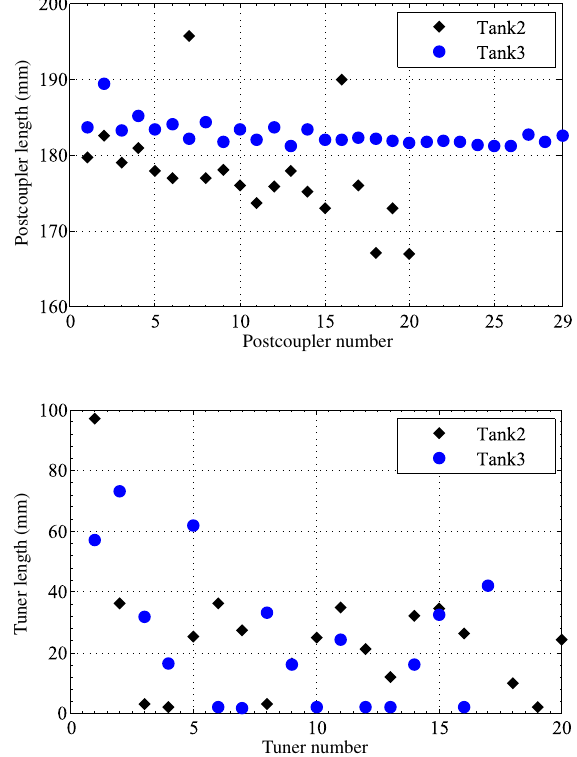
FIG. 10. Top: post-coupler lengths, bottom: tuner lengths of Tank 2 (diamonds) and Tank 3 (dots). The two post-couplers with exceptional over-length are due to an additional tuner piece that had been installed on these post-couplers for the compensation of the influence of the